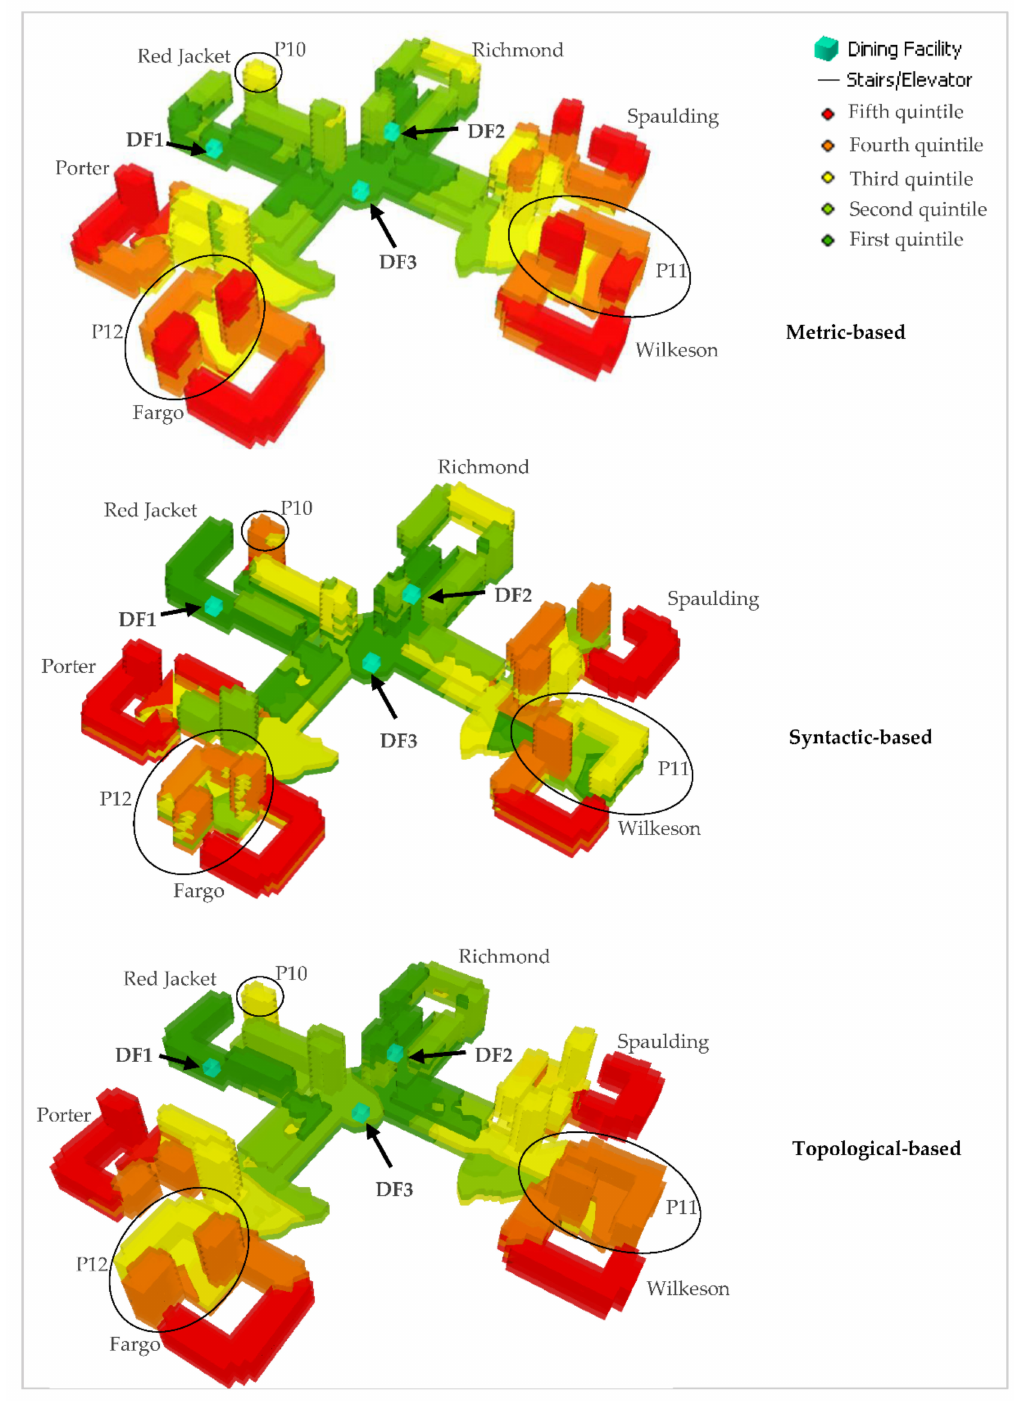
Figure 22. Metric, syntactic, and topological accessibility to three dining facilities: classification in